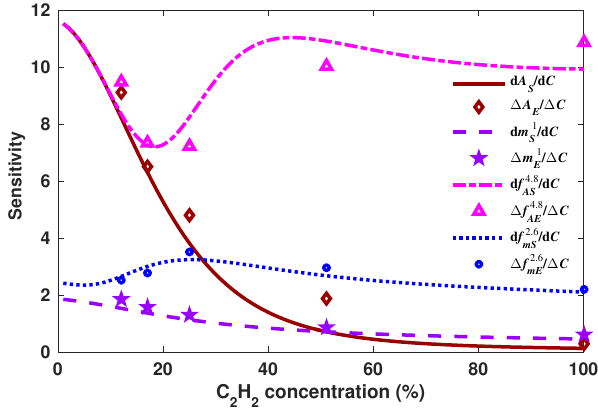
Figure 17. Simulated ( S ) and experimental ( E ) sensitivities for the generating functions f 4.8 for the peak amplitude ( A ) and the mean ( m 1